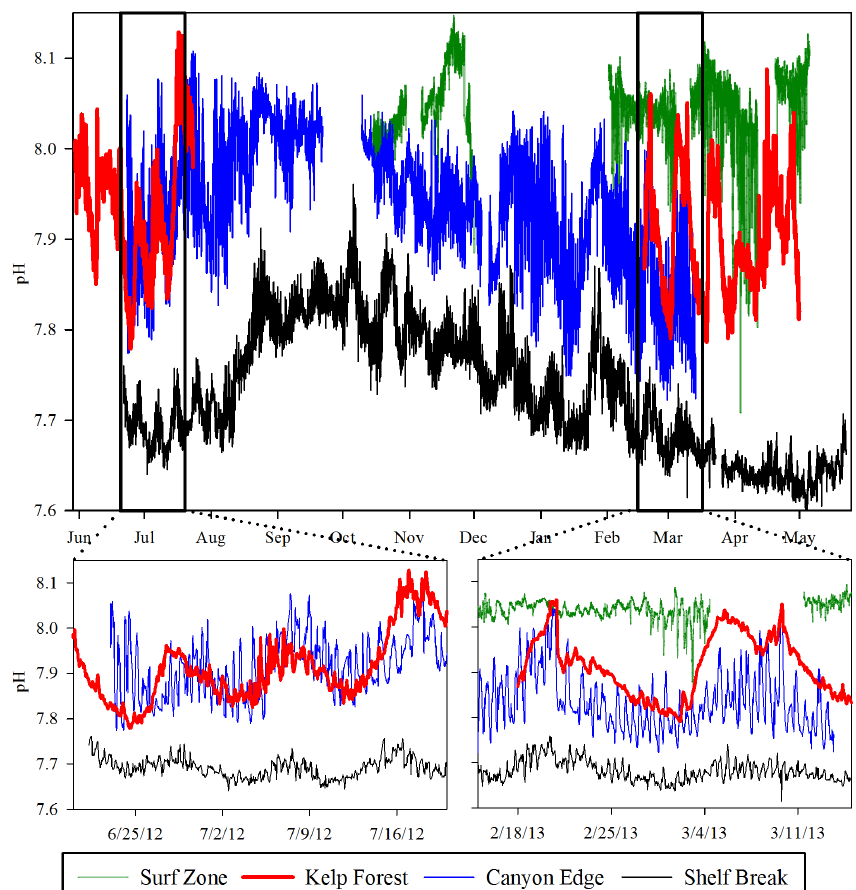
Figure 5. Time series of sensor pH between June 2012 and June. The two lower panels are month-long snapshots. pH is reported at in situ conditions.